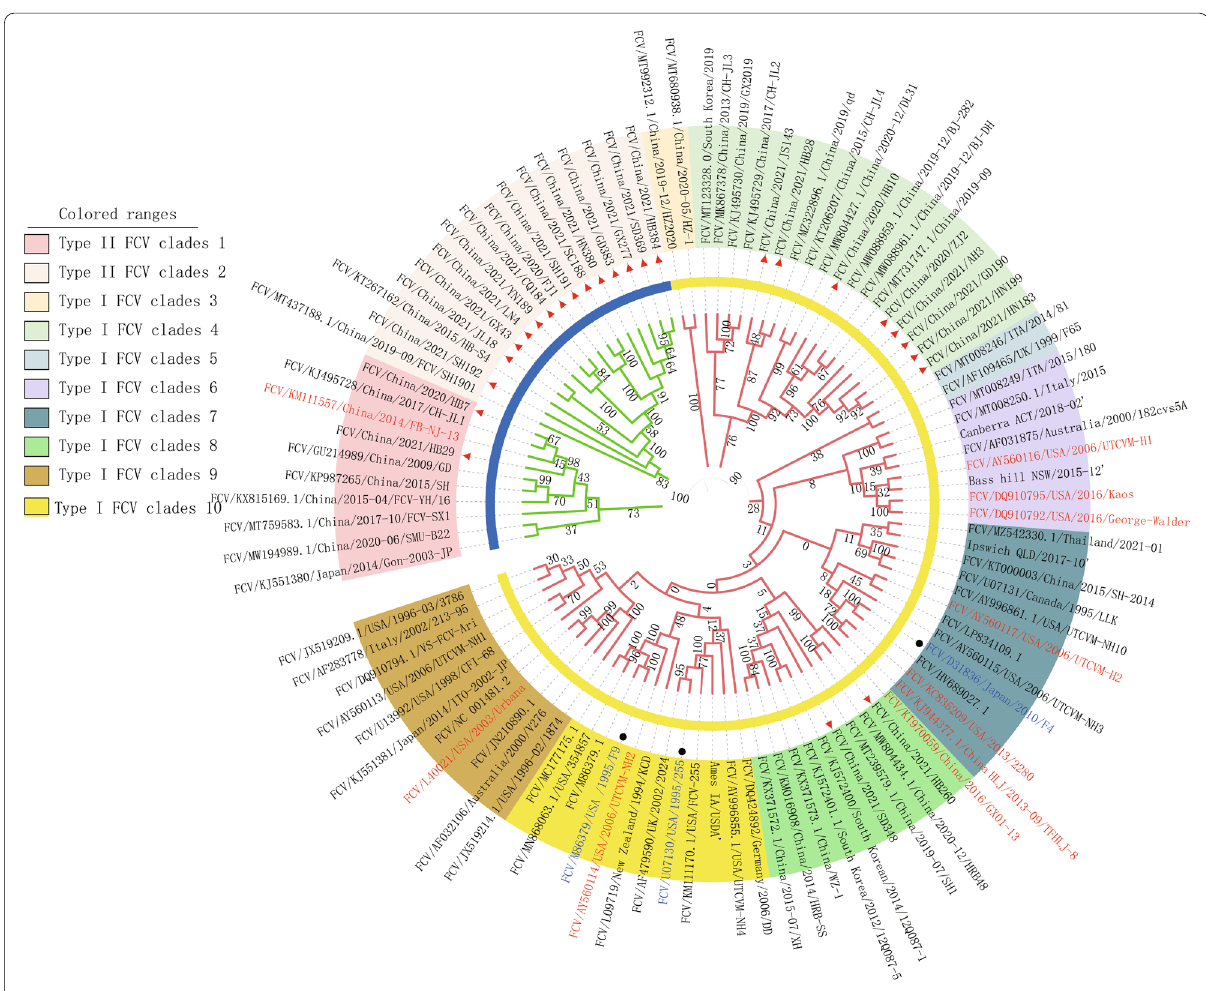
Fig. 2 ORF2 nucleotide sequence-based phylogenetic tree of 26 new isolates and reference strains retrieved from GenBank. Phylogenetic trees were constructed by the neighbor-joining method with 1000 bootstrap replicates using a Kimura 2-parameter model in the MEGA x software package. The 26 new isolates are marked with red triangles ( ), and the vaccine strains are marked with black spot ( ● ). The genotype I branch is marked in red, and the genotype II branch is marked in green. Reference strains and GenBank accession numbers are indicated on the branch, and VSD strain names are in red